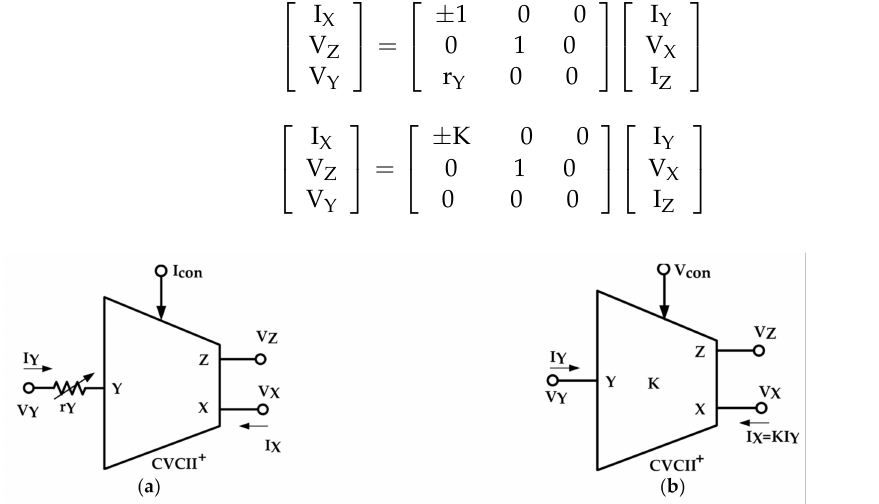
Figure 1. Symbolic representation of second generation voltage conveyor (CVCII+) with ( a ) variable impedance at Y port and ( b ) variable current